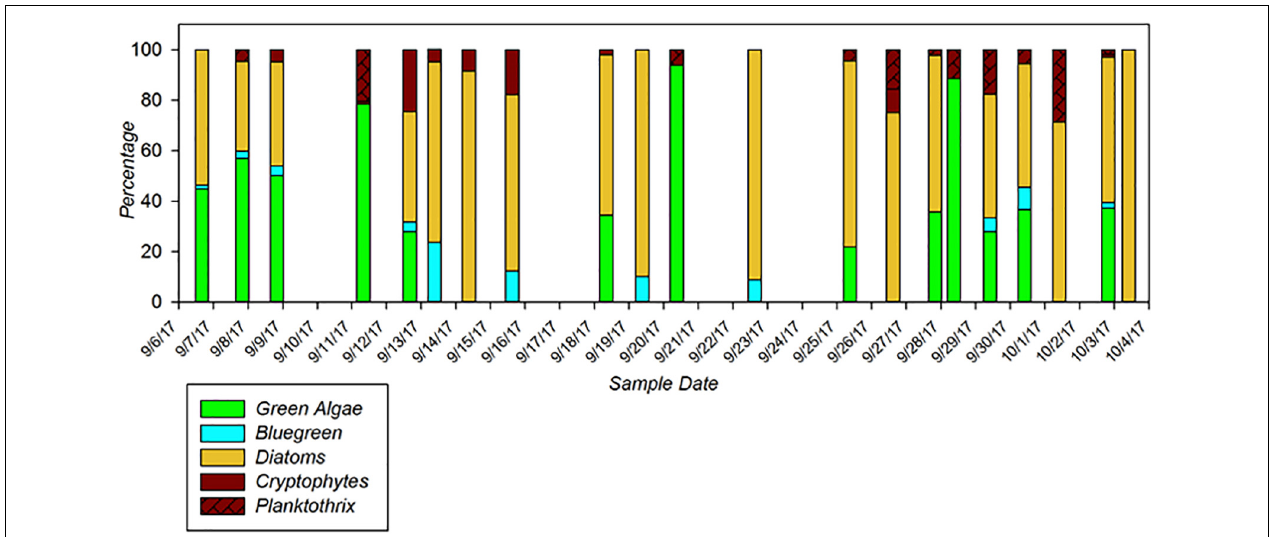
FIGURE 1 | Phytoplankton group classifications generated by the Moldaenke Gmbh PhycoProbe TM during a 2-week moored deployment in the Chesapeake Bay during the ACT performance verification of in situ fluorometers for detecting HABs. Colors indicate major phytoplankton groups, including green algae (green), cyanobacteria/bluegreen algae (blue), diatoms (orange), cryptophytes (brown), and the cyanobacteria Planktothrix (brown, hatched). Modified from ACT Verification Report (www.act-us.info/evaluations.php).